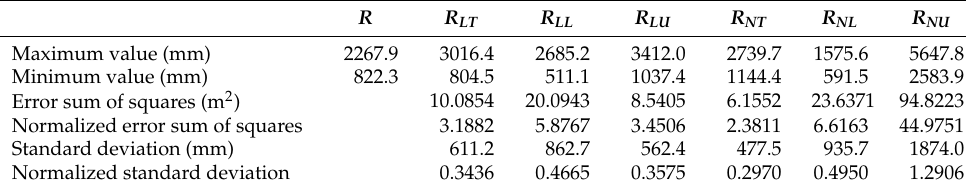
Table 10. Statistics of rainfall predictions for 149 potential LSL